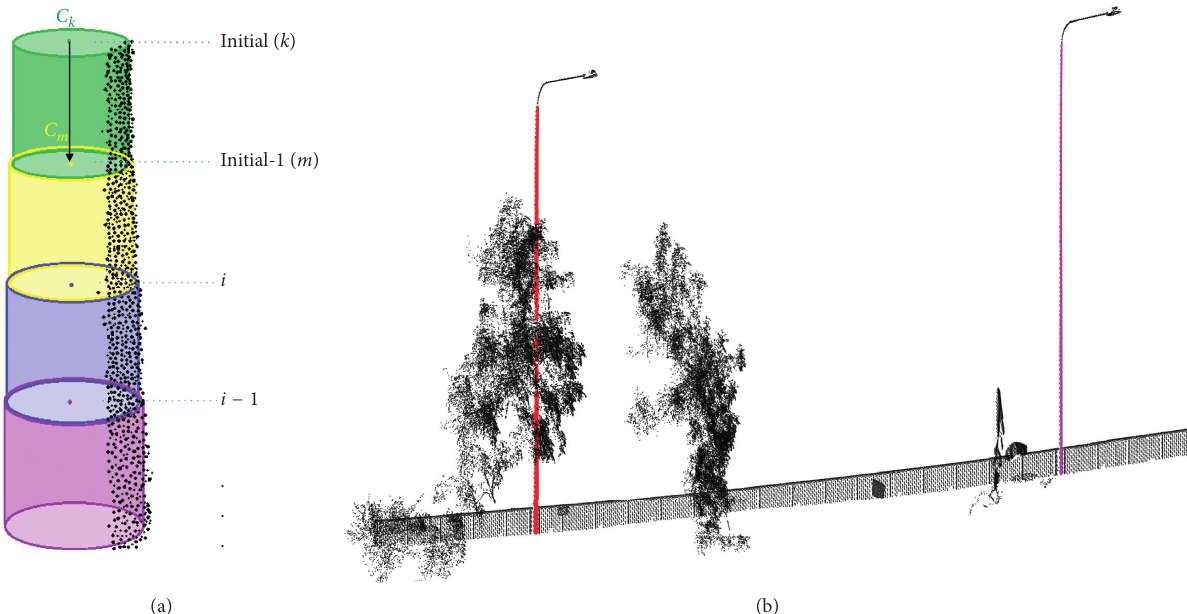
Figure 9: Cylindrical growing model. (a) Cylindrical growing with an adaptive pole diameter. (b) The two complete pole